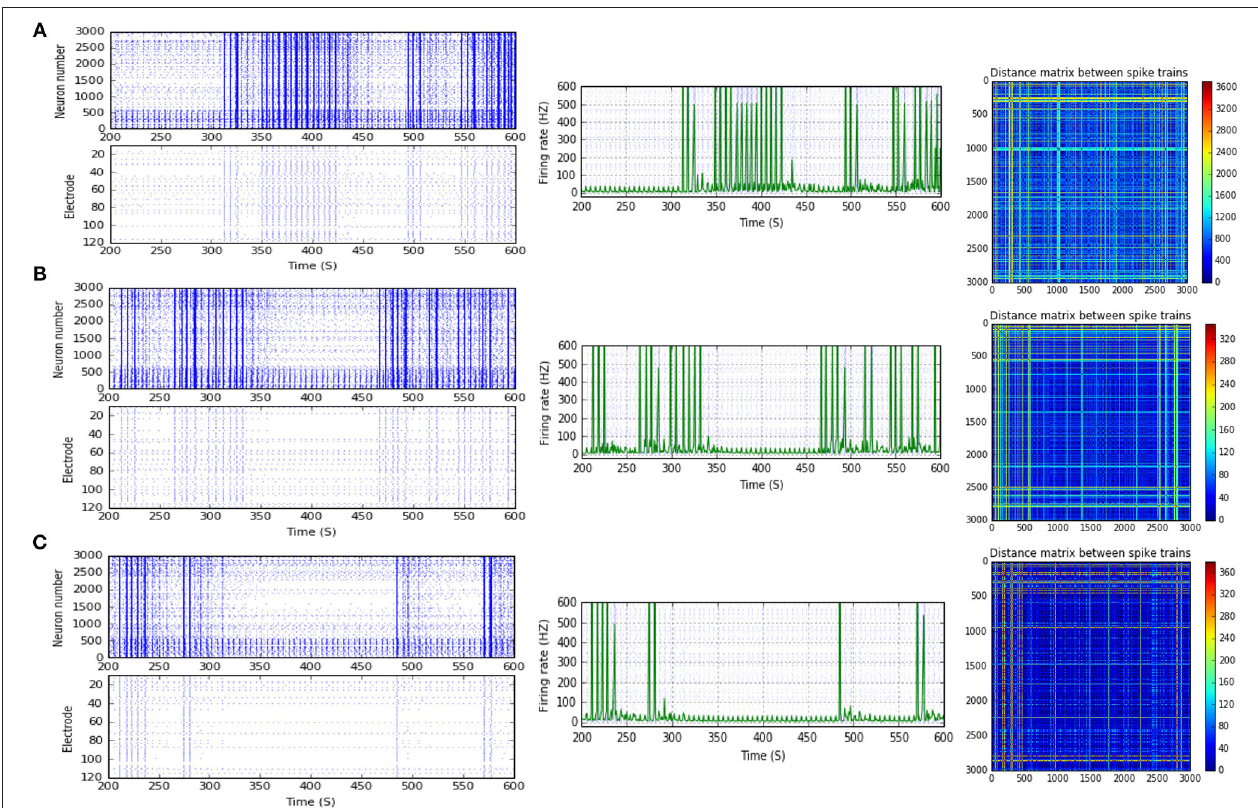
FIGURE 8 | Selected elicited firing response activity in the immature network scenario (B-2) before and after implementing STF1 and STF2 (when IF range of beta). (A) refers to the condition without implementing dynamical synapses (control) while (B,C) refer to that after implementing facilitating synapses (STF1 and STF2, respectively). The first two figures of each panel refer to monitoring the pattern of firing activity in time windows from 200 to 600 seconds(s). Heat maps of each panel represent modulation changes in spike distance matrix of the network scenario (B-2) before and after implementing STF1 and STF2. The simulation time for heat maps of the spike distance is equal to